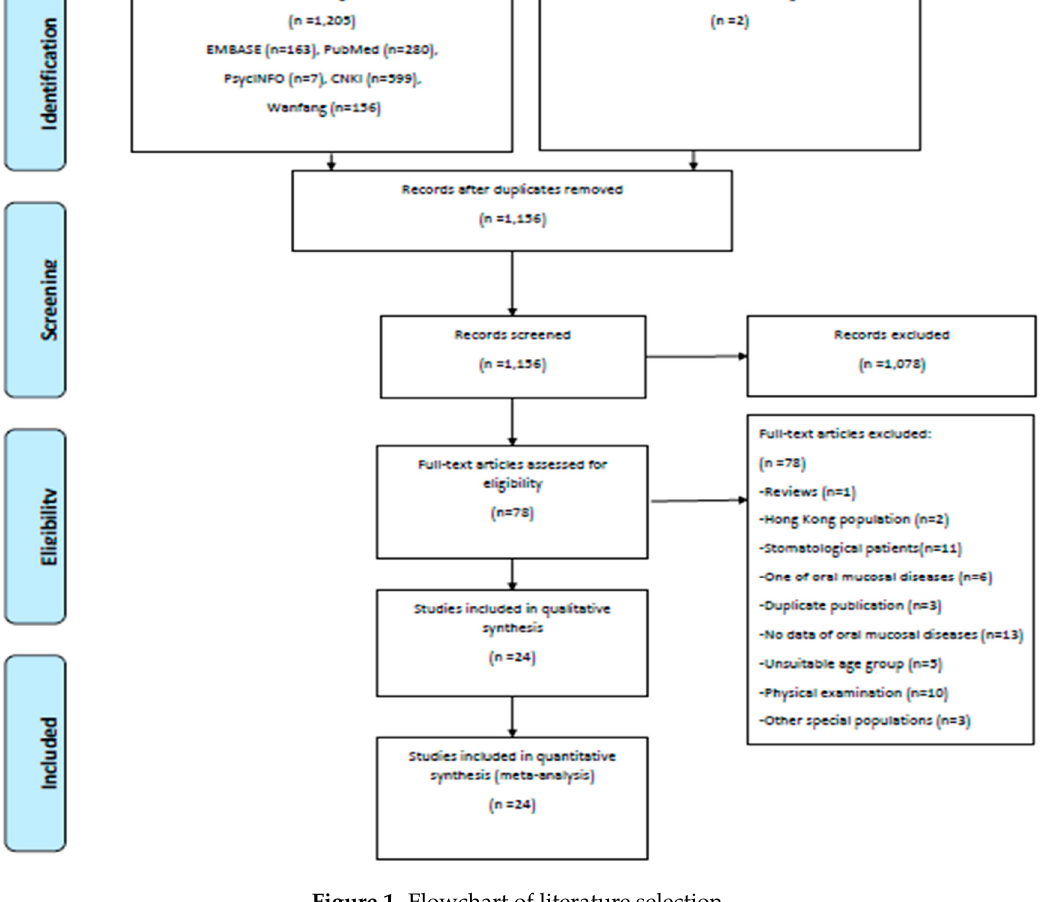
Figure 1. Flowchart of literature selection.